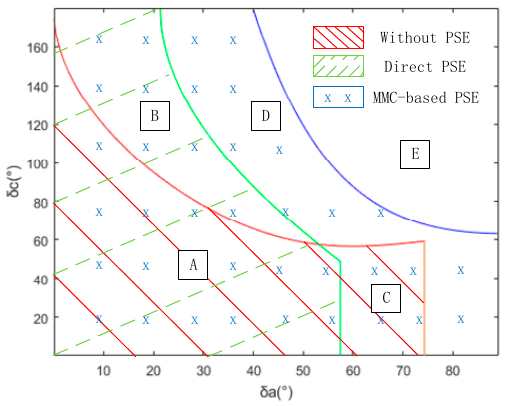
K = 1. Figure 7. Cross-sectional view of the three technologies at K DAR = 1. DAR K = 1. DAR